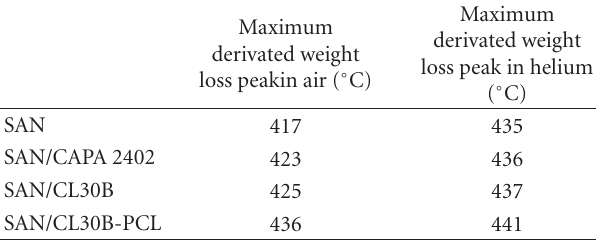
Table 3: Values of the maximum derivated weight loss peaks obtained from thermogravimetric analysis (DTG) in air and in helium, at 20 ◦